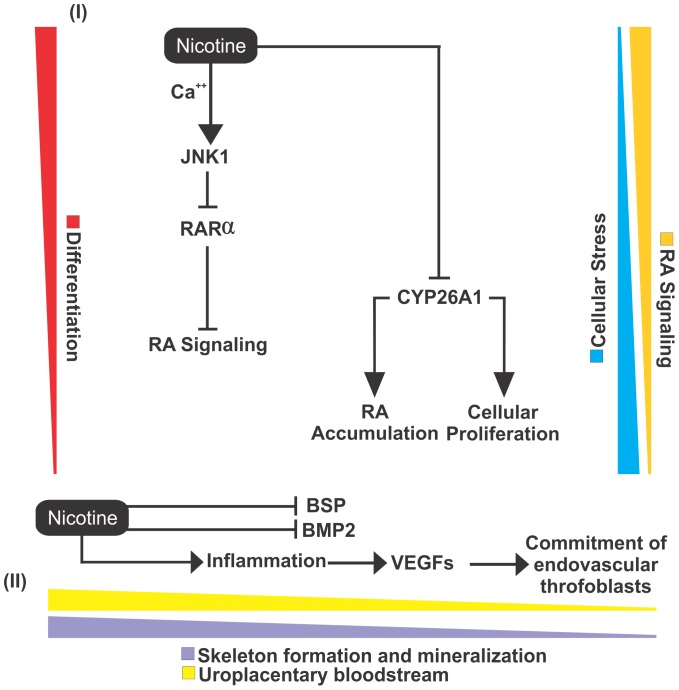
A molecular model illustrating how nicotine could potentially affects differentiation.In the first part of the model (I), it can be observed that by generating cellular stresses, nicotine promotes the recruitment of JNK1 through the influx of intracellular Ca2+. JNK1, by itself, promotes the inhibition of RARα. Finally, nicotine promotes the inhibition of CYP26A1, which generates an accumulation of RA in the cell and an increase in cell proliferation. In the second part of the model (II), the inhibition of BMP2 and BSP is promoted by nicotine, which results in the negative regulation of bone mineralization and skeletal development. In addition, nicotine promotes a pro-inflammatory reaction that recruits VEGF and placental growth factors, which leads to an impairment of the endovascular trophoblast, resulting in a fetal growth restriction.